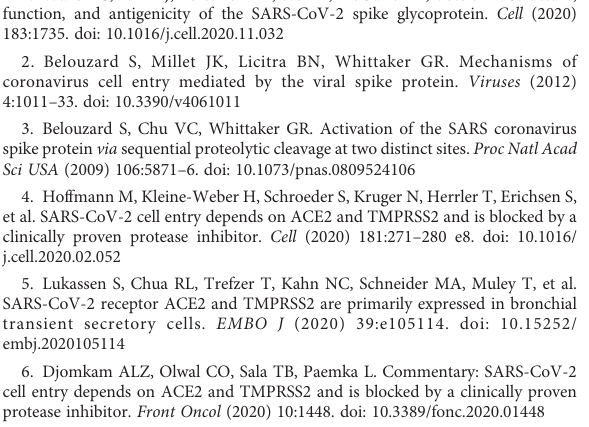
Cluster heatmap of differently regulated genes among the spike- transfected and mock